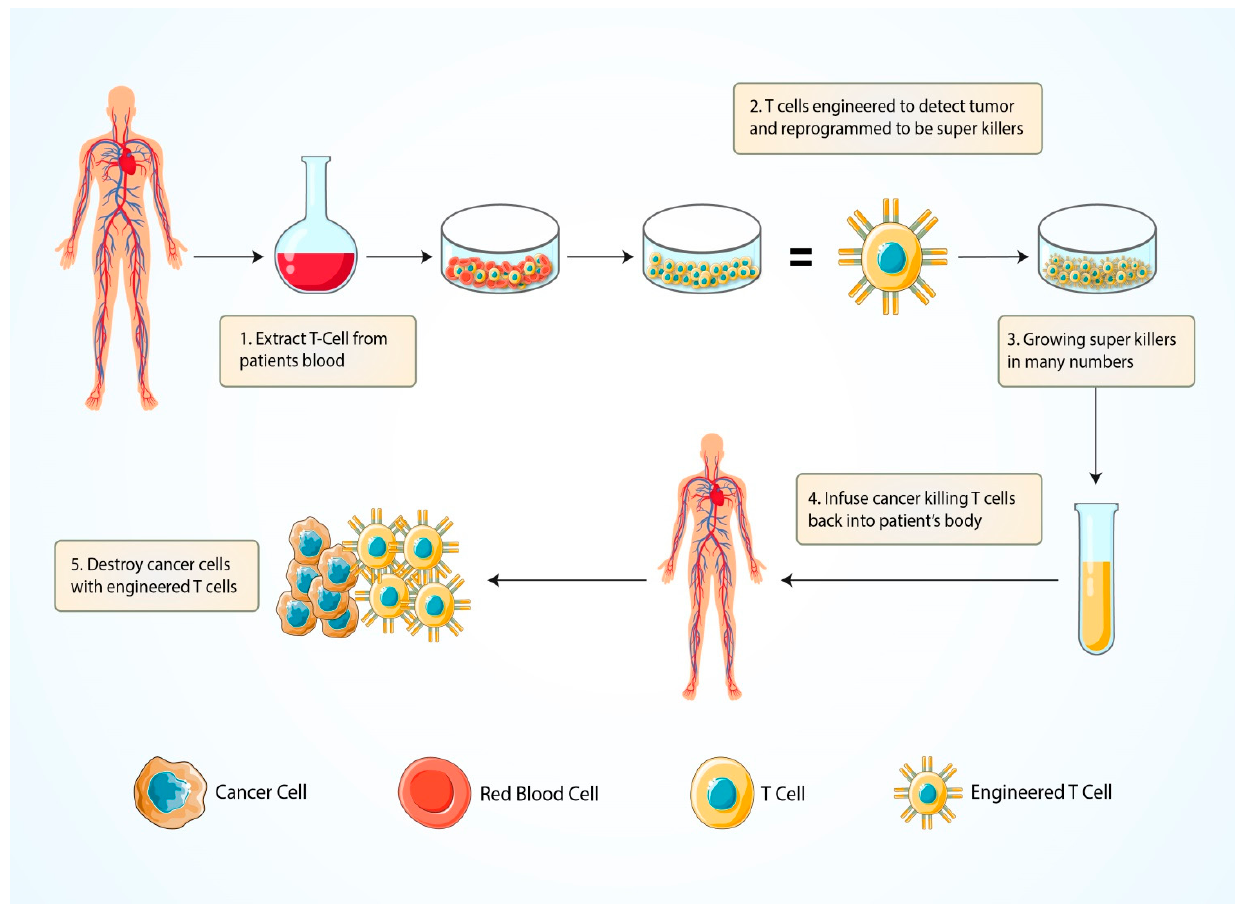
Figure 5. The mechanistic demonstration for the production of high efficiency cancer killing T cells. T cells are modified in order to make them more effective to kill cancer cells. For this purpose, the extract of T cells is taken from patients. T cells are engineered so that they can recognize tumor cells and, then, they are reprogrammed to generate super killer cells. The super killer T cells are expanded in vitro into multiple numbers. These T cells are infused back into patient’s body to work against cancer cells. Finally, the engineered T cells are able to destroy cancer cells.